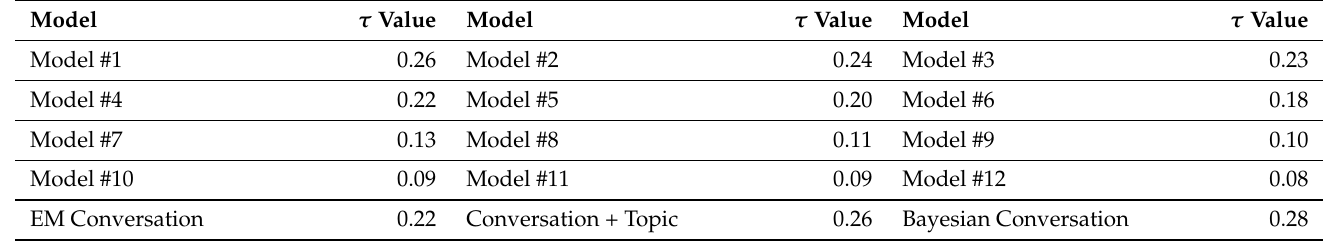
Table 2. Kendall’s τ for our twelve trained Hidden Markov Models (HMMs) and Ritter’s